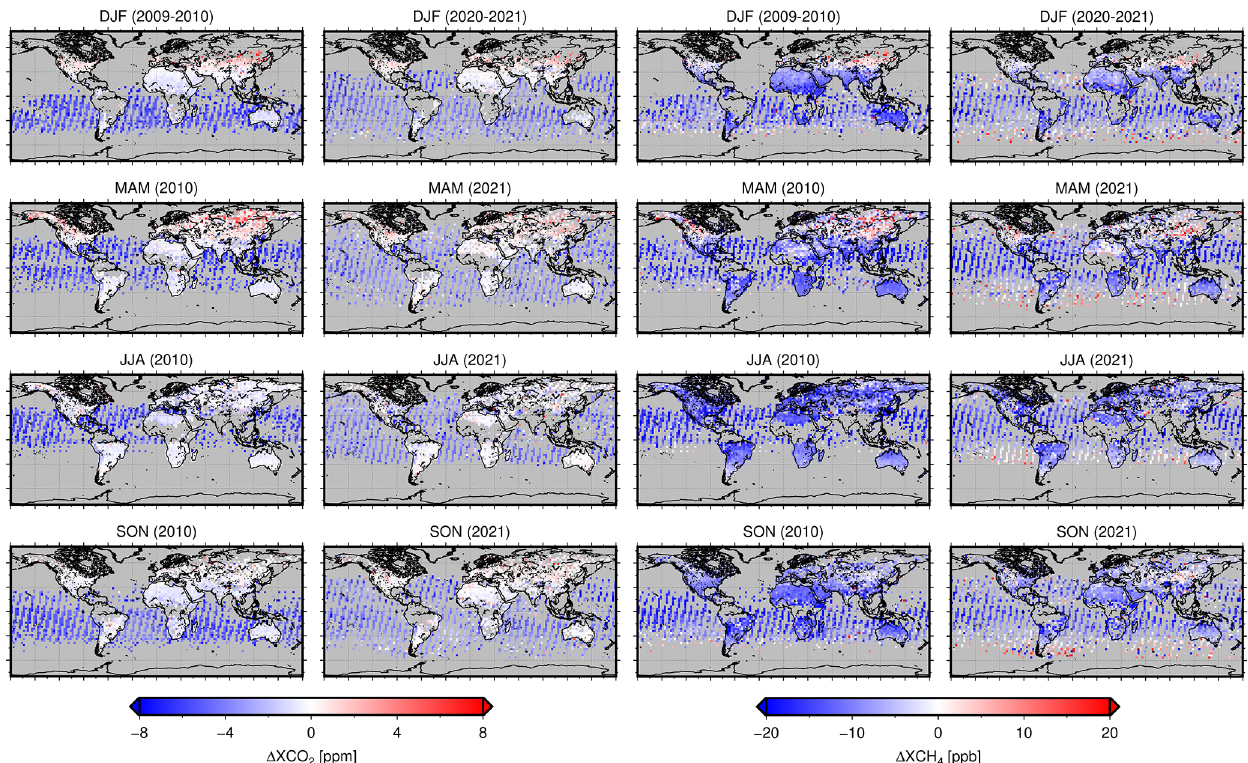
Figure 8. Global distributions of the differences in seasonal mean XCO 2 (left eight panels) and XCH 4 (right eight panels) in 2010 and 2021. The grid size is the same as Fig. 5. All the observations were used for each